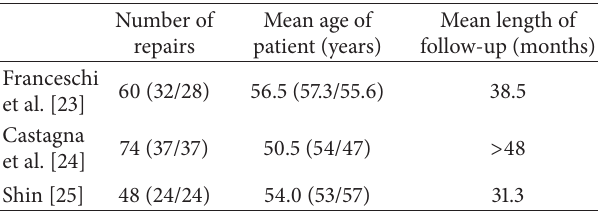
Table 2: Patient